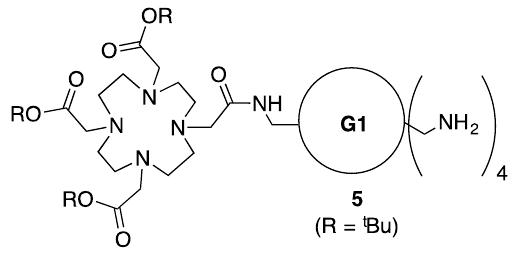
Figure 6. Intermediate 5 . Figure 8. Intermediate 5